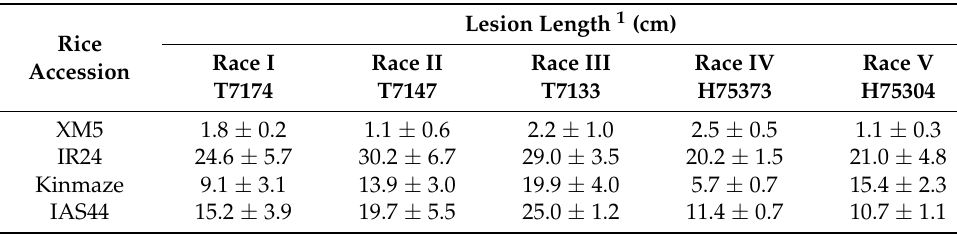
Lesion Length 1